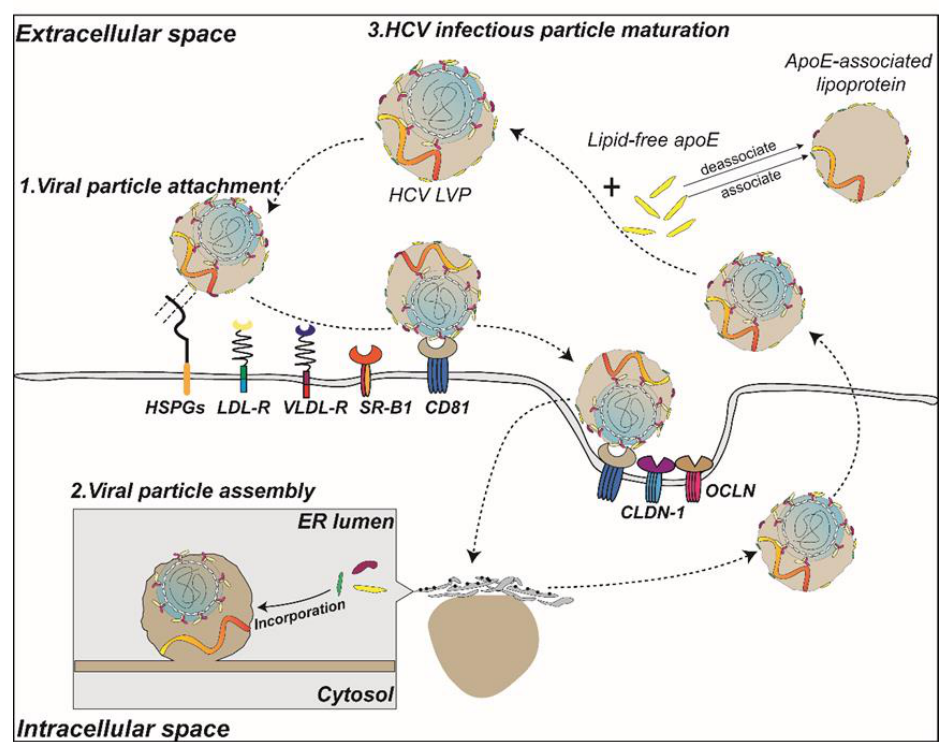
Figure 4. A model of the role of ApoE in the life cycle of HCV. The circulating HCV infectious particles bind to HSPGs and receptors (LDLr, VLDLr, and SR-B1) on the cell surface via ApoE prior to entering cells via interactions with CD81, claudin-1 (CLDN-1) and occludin (OCLN). Subsequently, in the lumen of the endoplasmic reticulum, apolipoproteins such as ApoE are incorporated into lipid droplets that encapsulate the HCV nucleocapsid, which is embedded with E1E2 heterodimers to participate in the assembly process. In addition, the binding of extracellular ApoE to secreted HCV particles assists in the maturation of HCV LVPs.